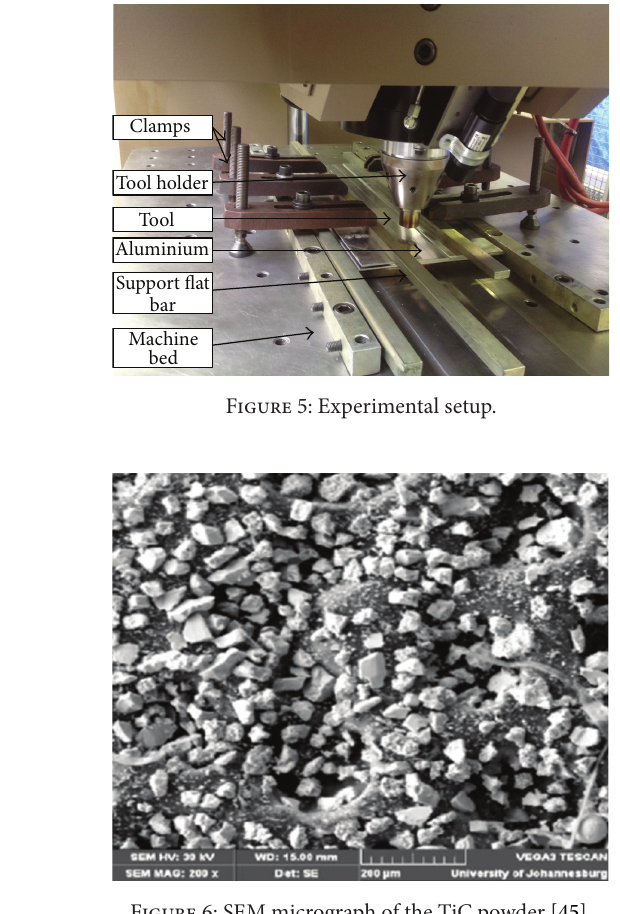
Figure 6: SEM micrograph of the TiC powder [45].